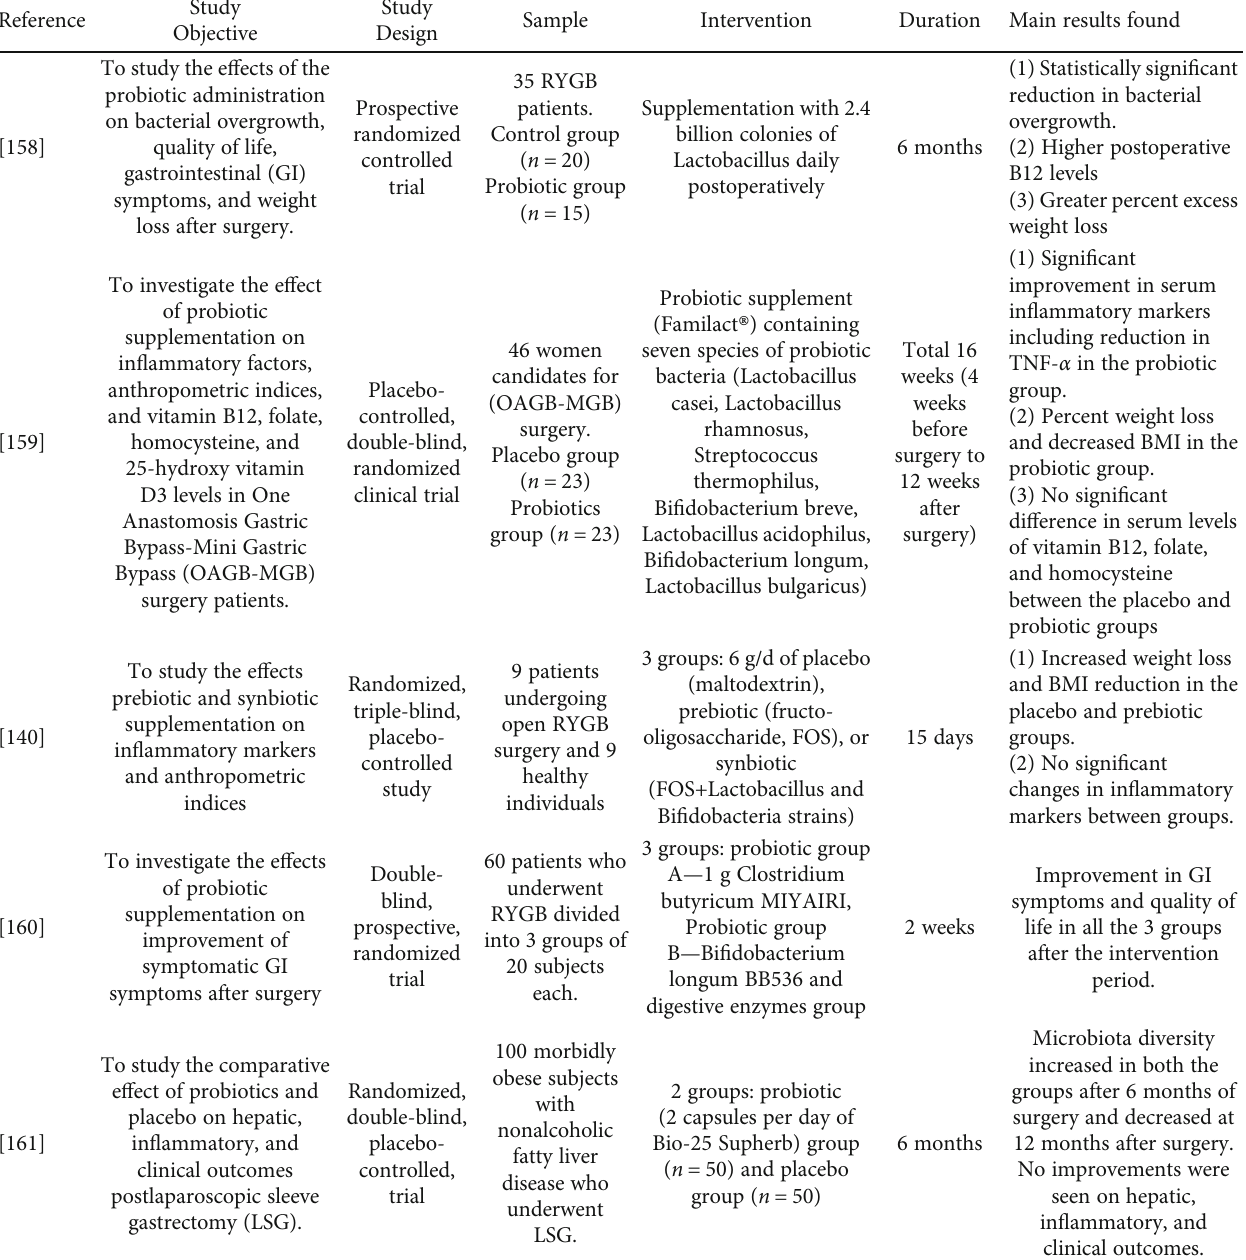
Table 2: Studies showing use of gut-targeting therapies/interventions in the bariatric surgery population.